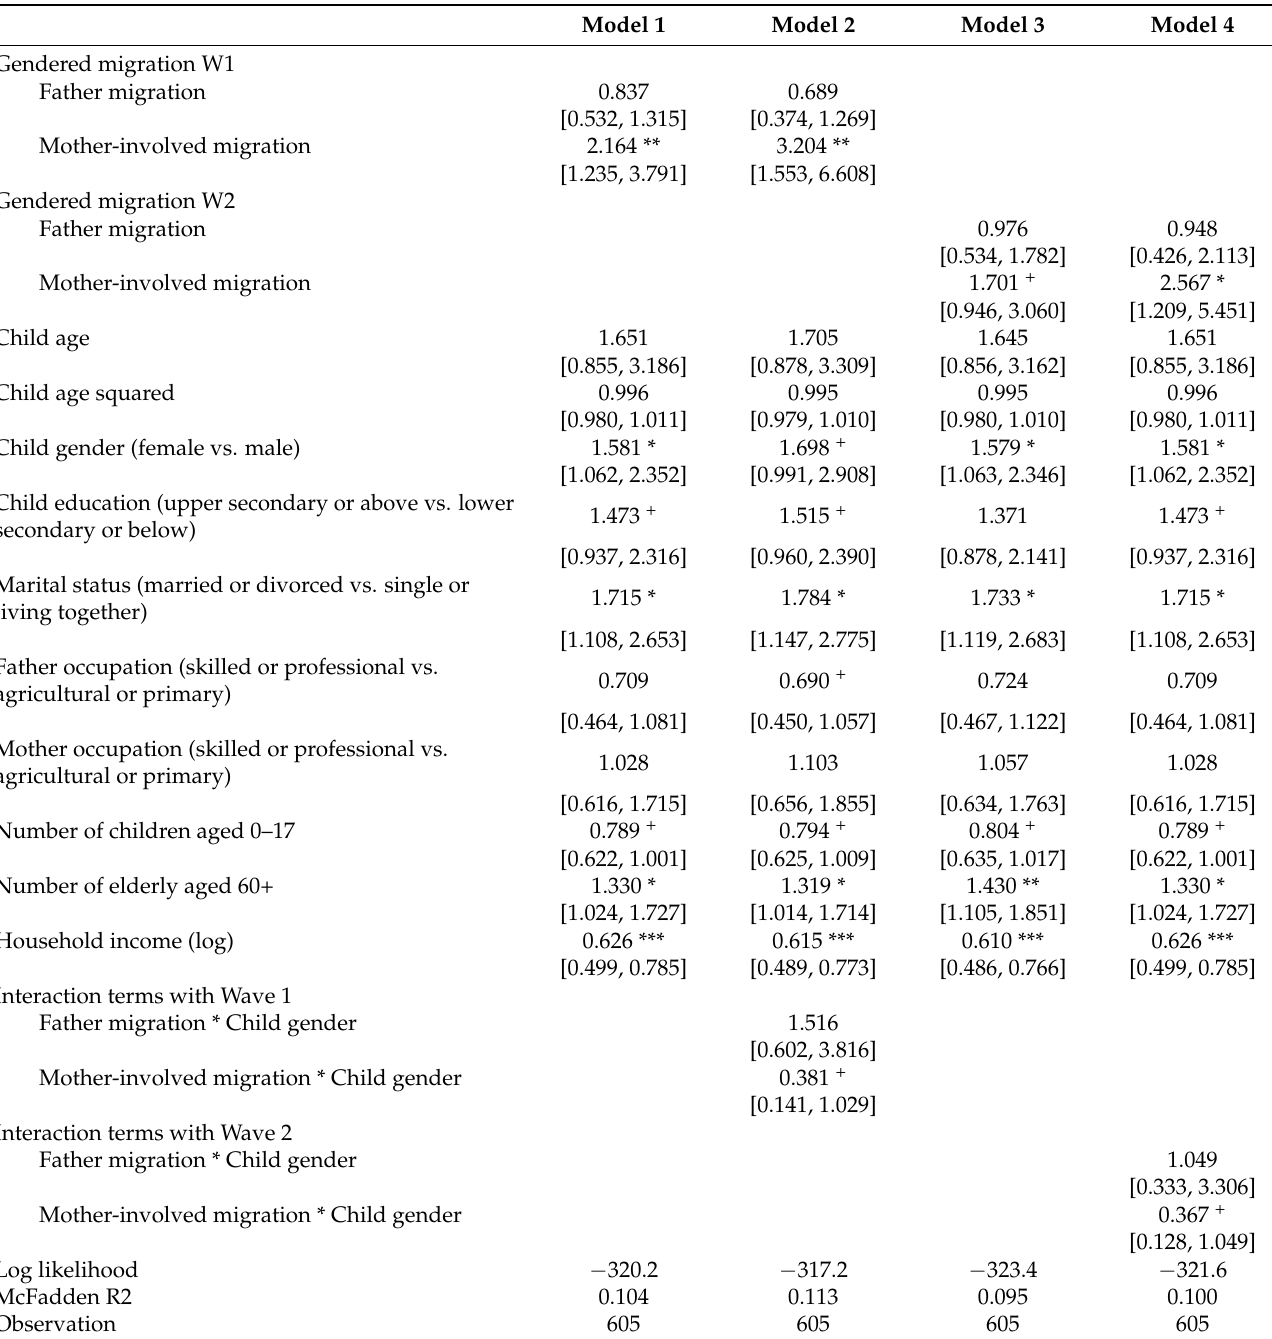
Table A1. Effects of gendered migration on youth migration with interaction terms.